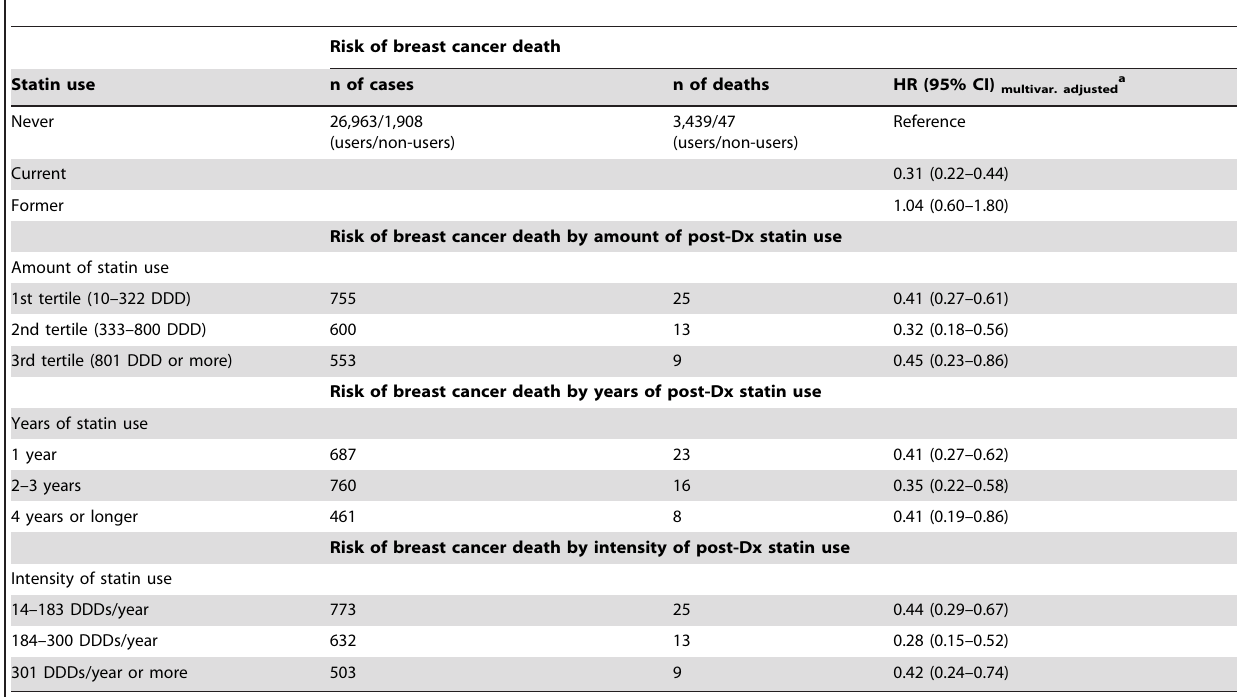
Table 7. Risk of breast cancer death by amount, years and intensity of post-diagnostic statin use as compared to non-users.